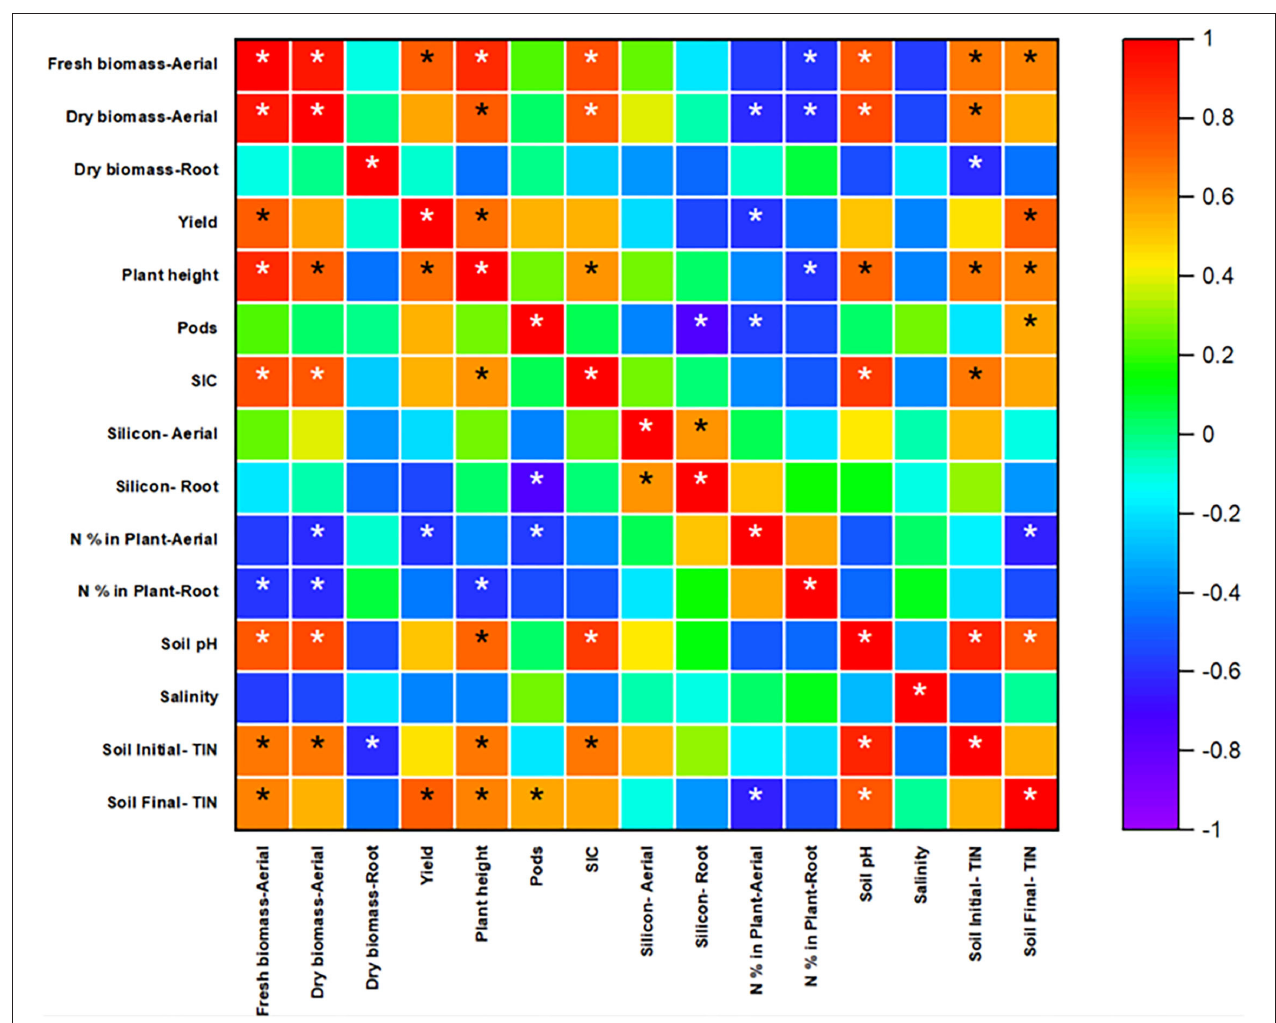
FIGURE 7 | Pearson’s correlation analysis for spring rye. The scale indicates the level of significance ( − 1 to 1) and stars indicate correlations that meet the significant level ( p < 0.05).